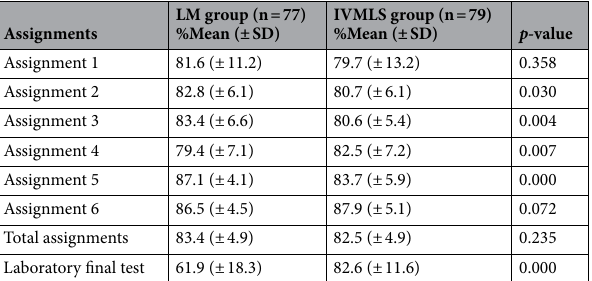
Table 2. Comparison of student performance in homework assignments and laboratory final test before and after the application of IVMLS. LM light microscope, IVMLS interactive virtual microscope laboratory system, n number of students.